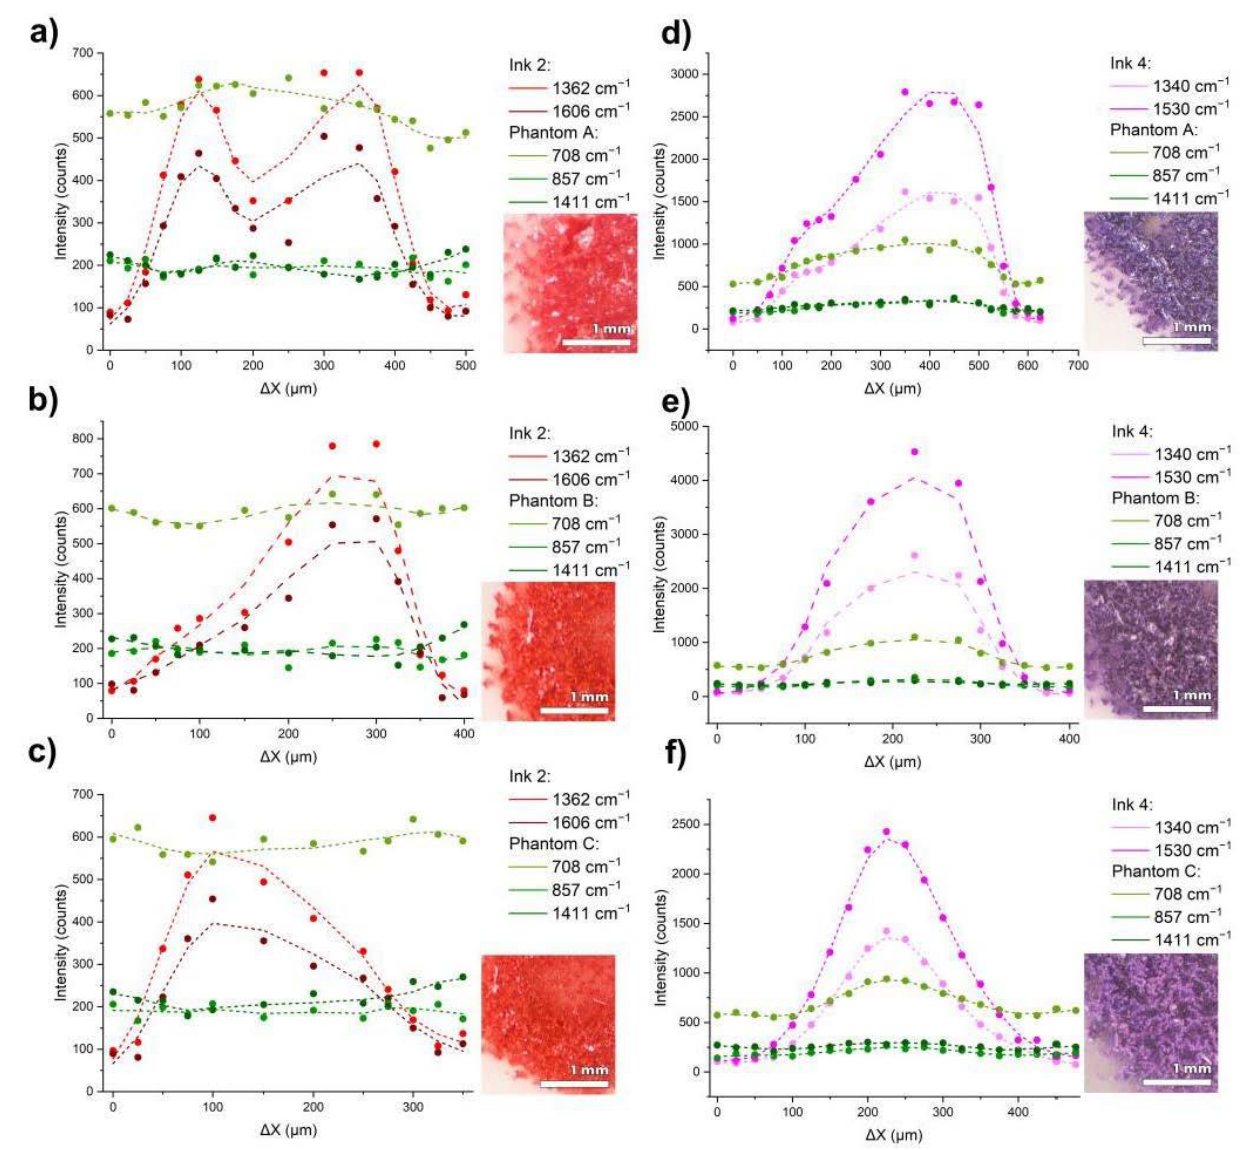
Figure 7. The intensity of the characteristic bands for tattoos made with Ink 2 in Phantoms A, B, and C ( a – c ), tattoos made with Ink 4 in Phantoms A, B, and C ( d – f ), and phantoms themselves in the offset function of the measurement point. The insets present magnified microscopic images of the tattooed dots.